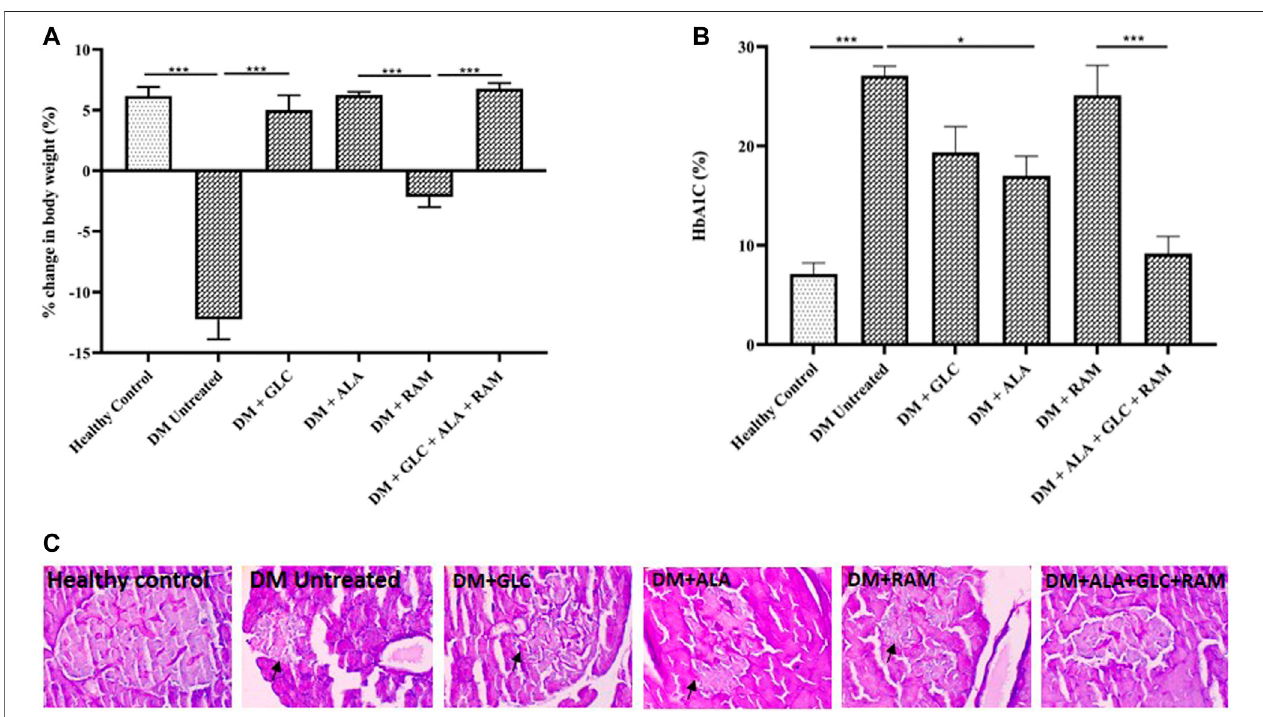
FIGURE 1 | Changes in body weight, HbA1c level and pancreas histology. (A) Percentage change in body weight, (B) HbA1c level and (C) representative photomicrographs of PAS-stained images of pancreatic tissues from all groups. Arrows point to damaged pancreatic islet. Magni fi cation ×400. Healthy control ( n = 7); DM Untreated = Untreated diabetes mellitus rats ( n = 9); DM + GLC = Diabetic rats treated with gliclazide ( n = 7); DM + ALA = Diabetic rats treated with alpha-lipoic acid ( n = 7); DM + RAM = Diabetic rats treated with ramipril ( n = 7); DM + ALA + GLC + RAM = Diabetic rats treated with alpha-lipoic acid, gliclazide and ramipril ( n = 7). * p < 0.05 vs. diabetic control, ** p < 0.01 vs. diabetic control, *** p < 0.001 vs. diabetic